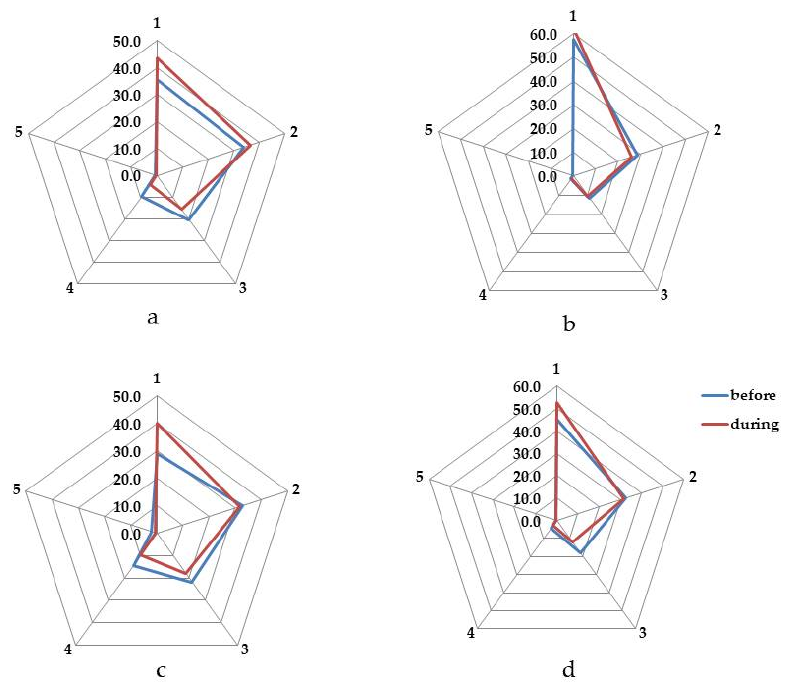
Figure 4. Categories of food waste (%). ( a ) fruits and vegetables; ( b ) meat and meat products; ( c ) bread and bakery products; ( d ) milk and dairy products.